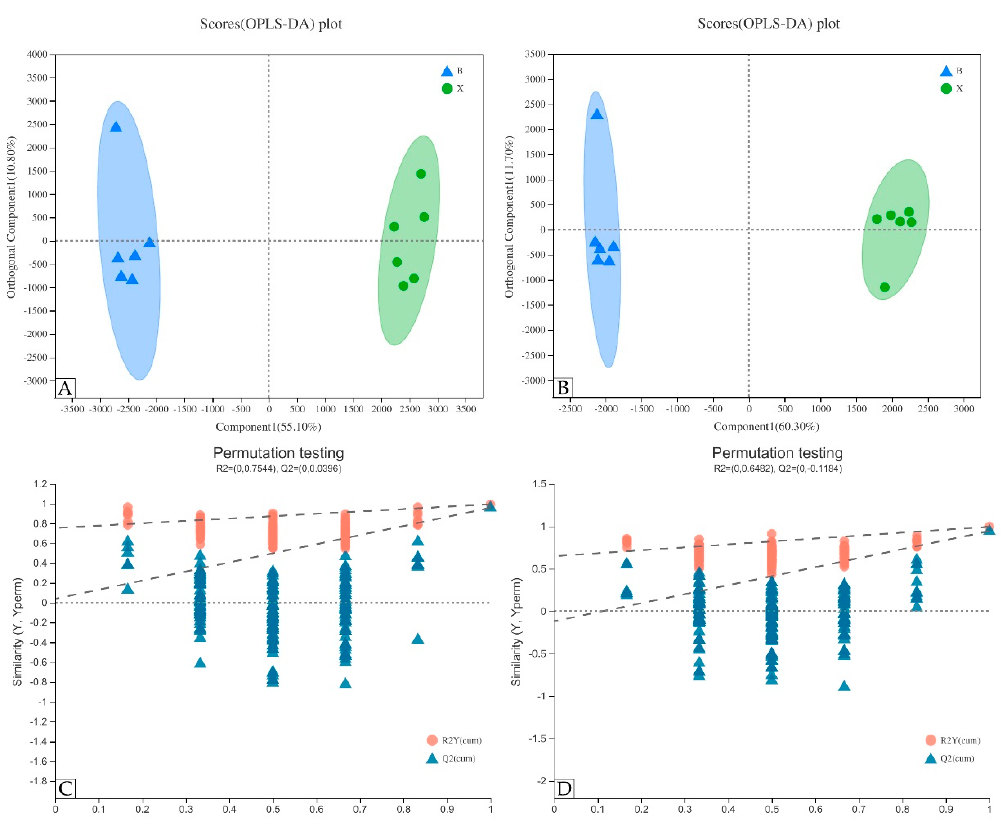
Figure 6. OPLS-DA model and permutation testing. ( A , B ) OPLS-DA scores plot in cationic and anion mode; ( C , D ) verification of OPLS-DA model of ( A , B ), respectively.